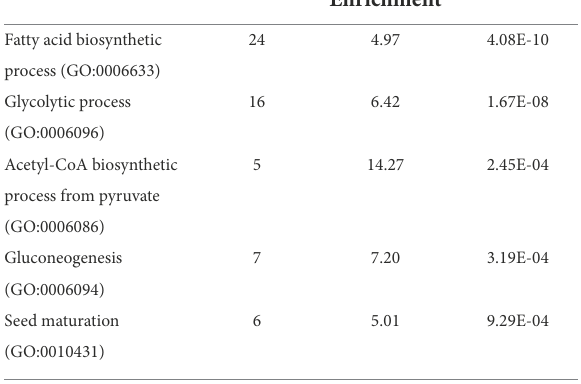
TABLE 3 GO term enrichment for 915 A. thaliana genes for which the AW-box is significantly over-represented in in the 500 bp upstream region and orthologous upstream regions